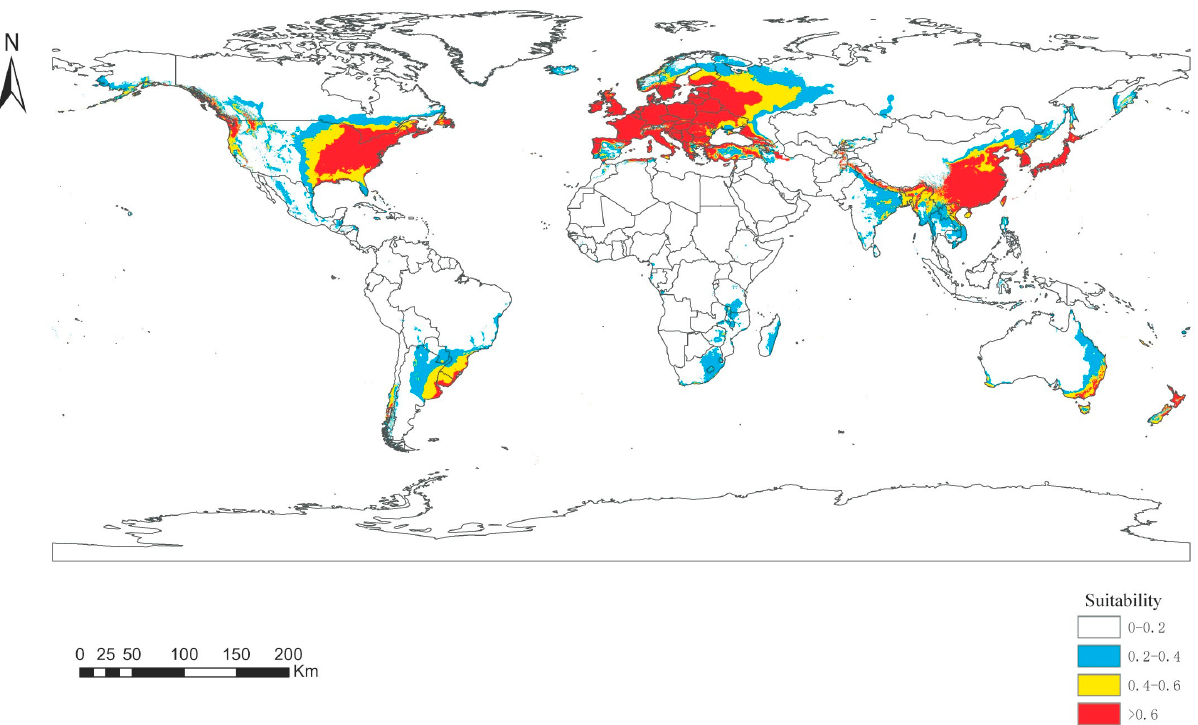
Figure 7. Distribution of the habitat appropriateness of Panorpidae under global warming.